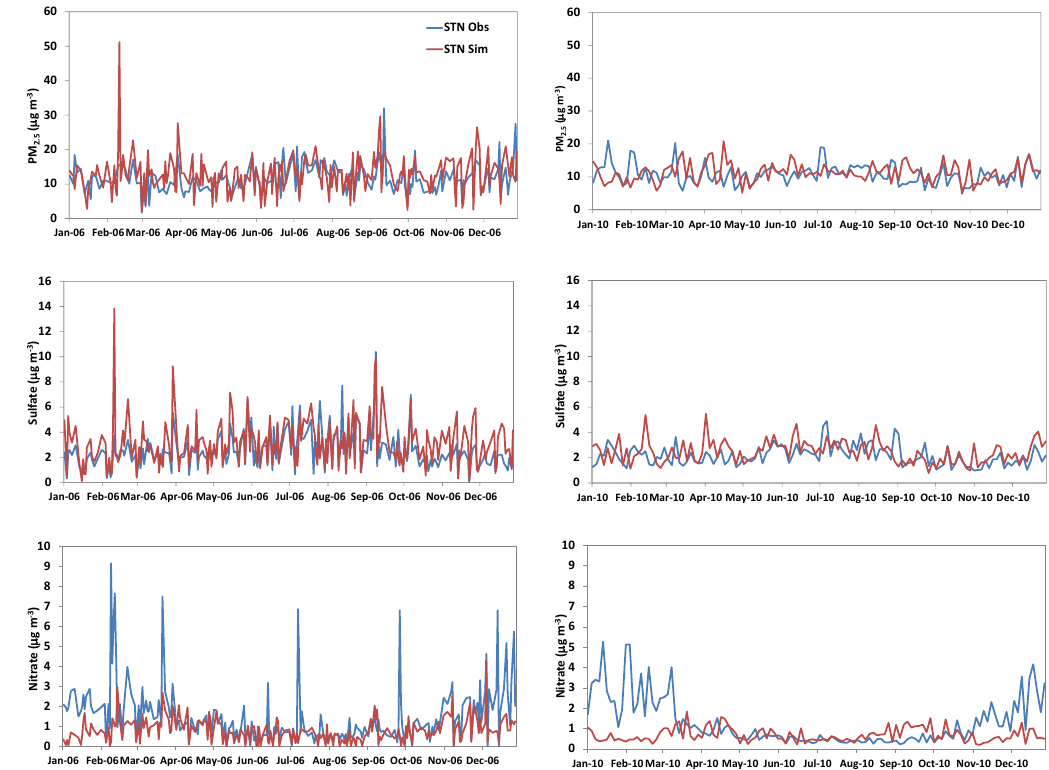
Figure 8. Time series of Obs vs. Sim PM 2 . 5 , SO 4 and NO 3 concentrations against STN for 2006 and